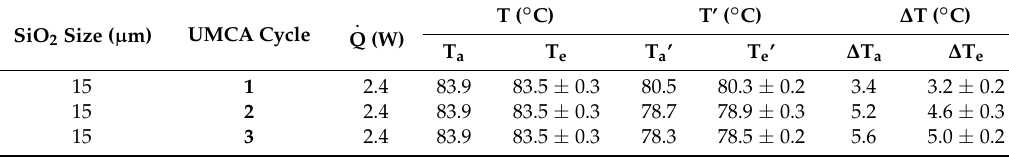
Table 5. Effects of UMCA cycles when comparing the temperatures obtained from the analytical model (all with subscript a) and the experiment (all with subscript e), using the 15 µ m SiO 2 powders for one to . three UMCA cycles and all under a total heat input power Q of 2.4 W. The coverage of the top surface is 34%, 54%, and 58% for cycles 1–3, respectively.